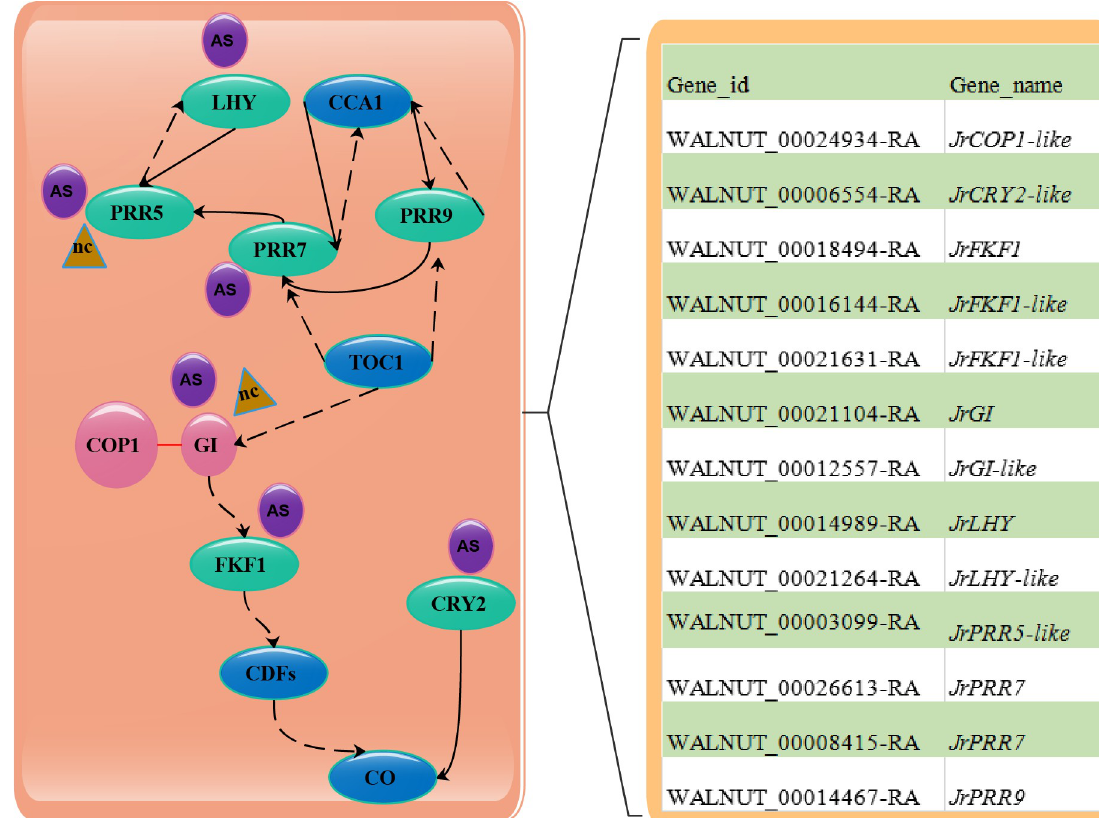
Fig 5. Hypothetical model for plant circadian rhythm genes regulating flower development in walnut. AS, alternatively splice; nc, long non-coding RNAs.